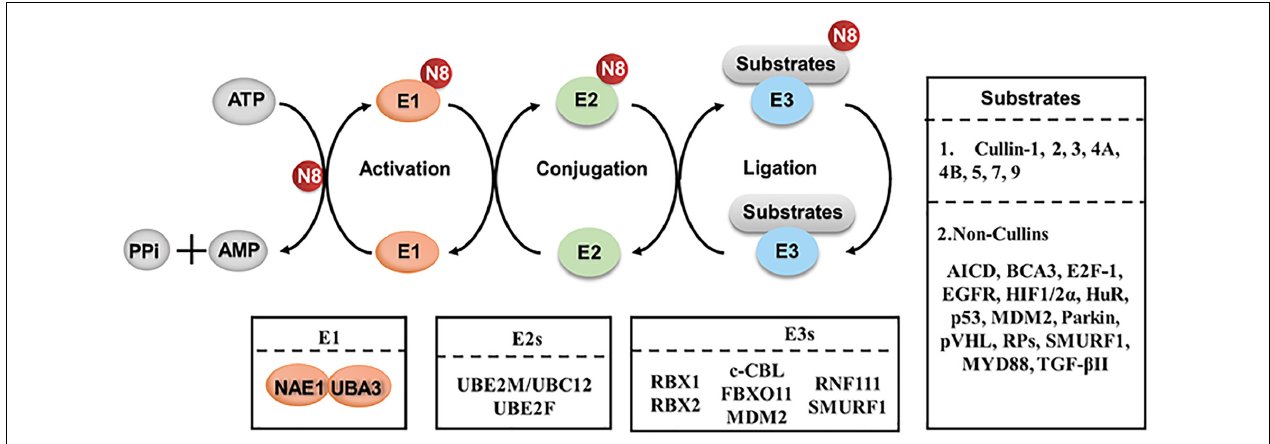
FIGURE 1 | The process of protein neddylation. Neddylation is a biochemical process of adding an ubiquitin-like protein, NEDD8, to substrates via a three-step enzymatic cascade involving NEDD8-activating enzyme El, NEDD8-conjuagating enzyme E2 and substrate specific NEDD8-E3 ligases. N8,